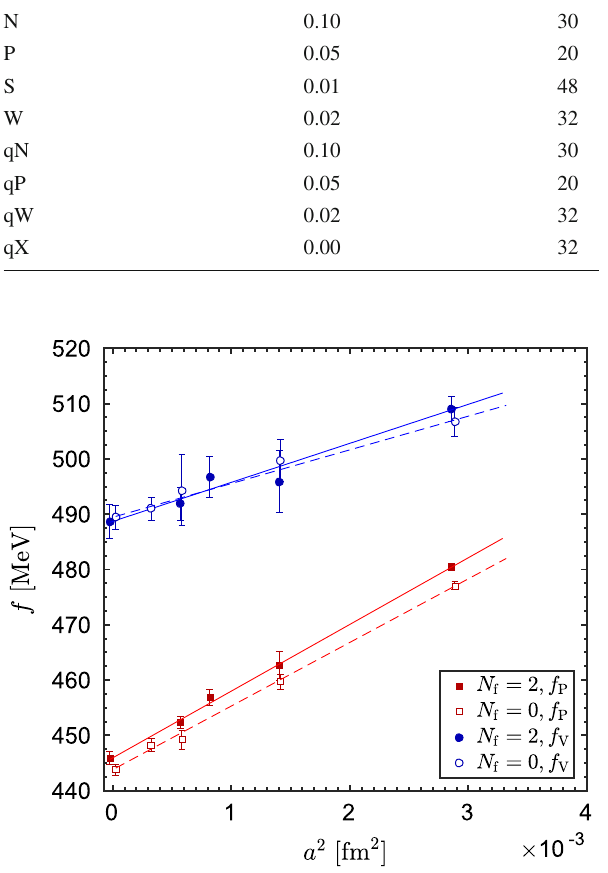
Fig. 4 Continuumextrapolationsofthemesondecayconstants f P and f V on our N f = 2 (full markers) and N f = 0 (empty markers) ensem- bles. The continuum limit values are slightly displaced horizontally. To √ t 0 = 0 . 1131 ( 38 ) fm [21] set the scale in physical units, we use